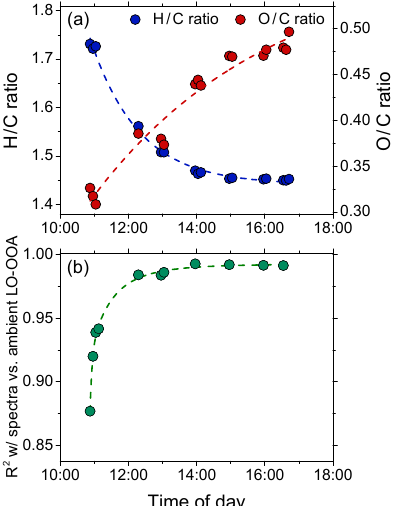
Figure 9. The evolution of organic aerosols inside the chamber dur- ing an ageing experiment (no. 8) in Beijing. Panel (a) the H / C and O / C ratios of organics on aged BC particles, (b) the correlation coefficients ( R 2 ) between the evolving total OA spectra in chamber experiment and the LO-OOA spectra derived from the Beijing field data